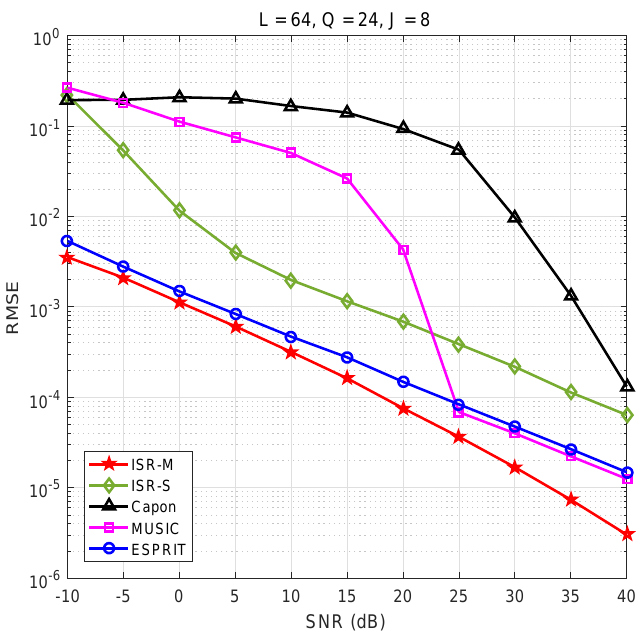
Figure 10. Comparison with existing MIMO radar target localization methods with K = 3, L = 64, Q = 24, and J = 8.